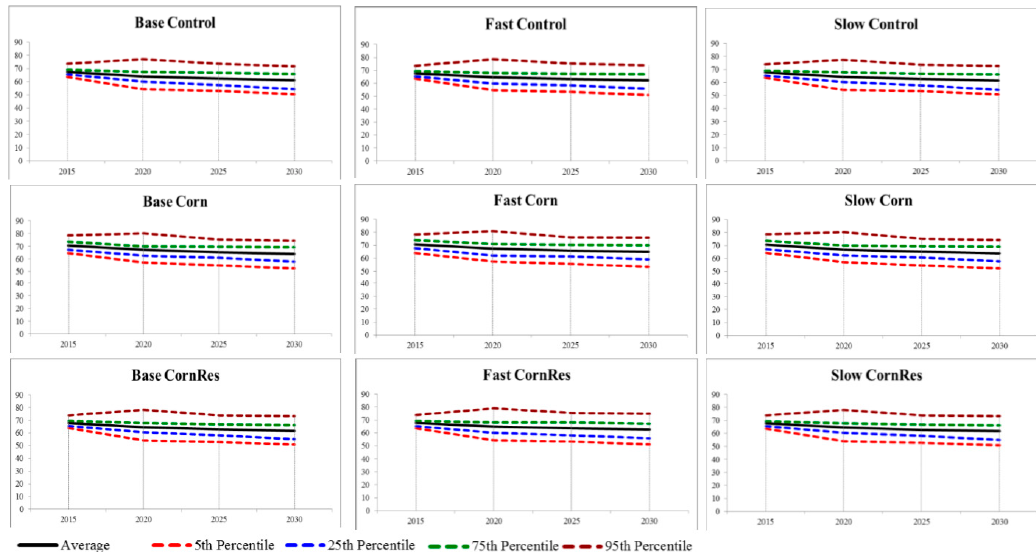
Figure A2. Variability of U.S. cropland used for crop production (in million acres) stochastic draw during 2015 to 2030 under various biofuel policy and demand growth scenarios.